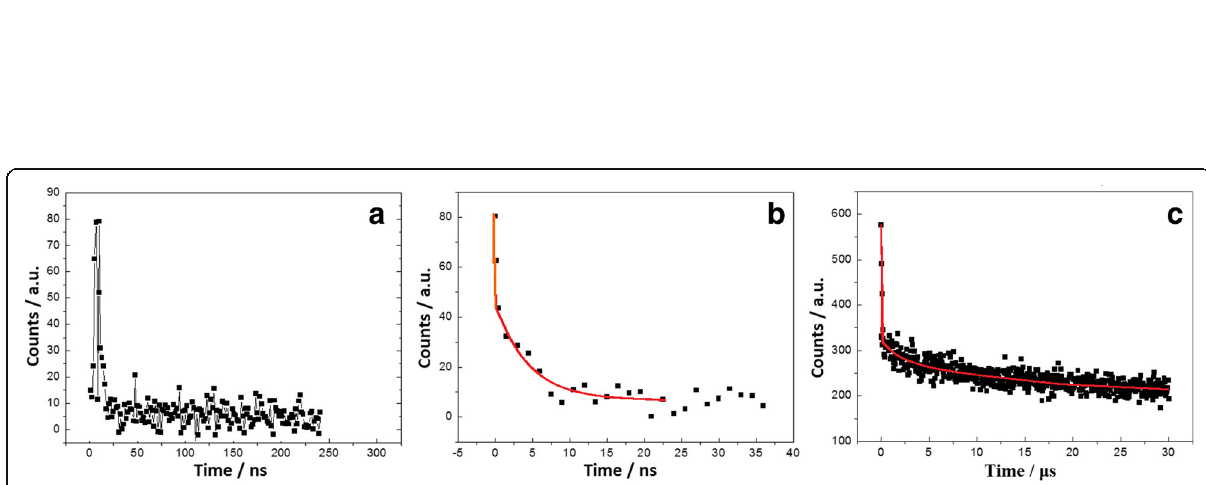
Fig. 5 a Optical image of Purcell cavity structure in micrometer scale on the BS surface. b Sharper PL peak with lasing near 600 nm measured at room temperature on Purcell cavity structure in a micrometer scale on the BS surface under excitation laser at 514 nm